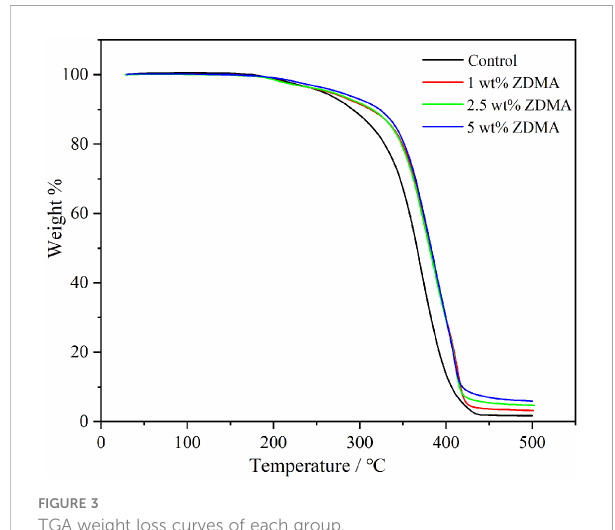
FIGURE 3 TGA weight loss curves of each